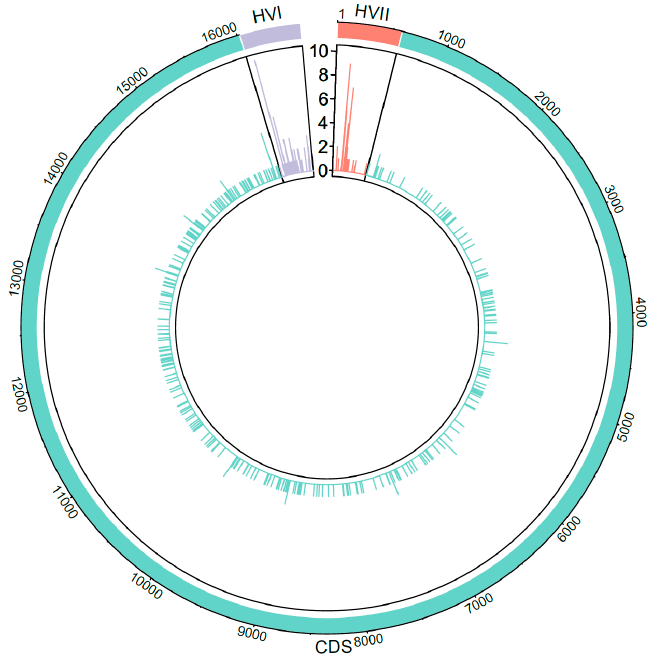
Figure 2. Distribution and count of the 446 observed point heteroplasmies across the mitochondrial genome including the two hypervariable (HVI and HVII) regions of the control region and coding region/sequence (CDS). Genes 2020 , 11 , x FOR PEER REVIEW